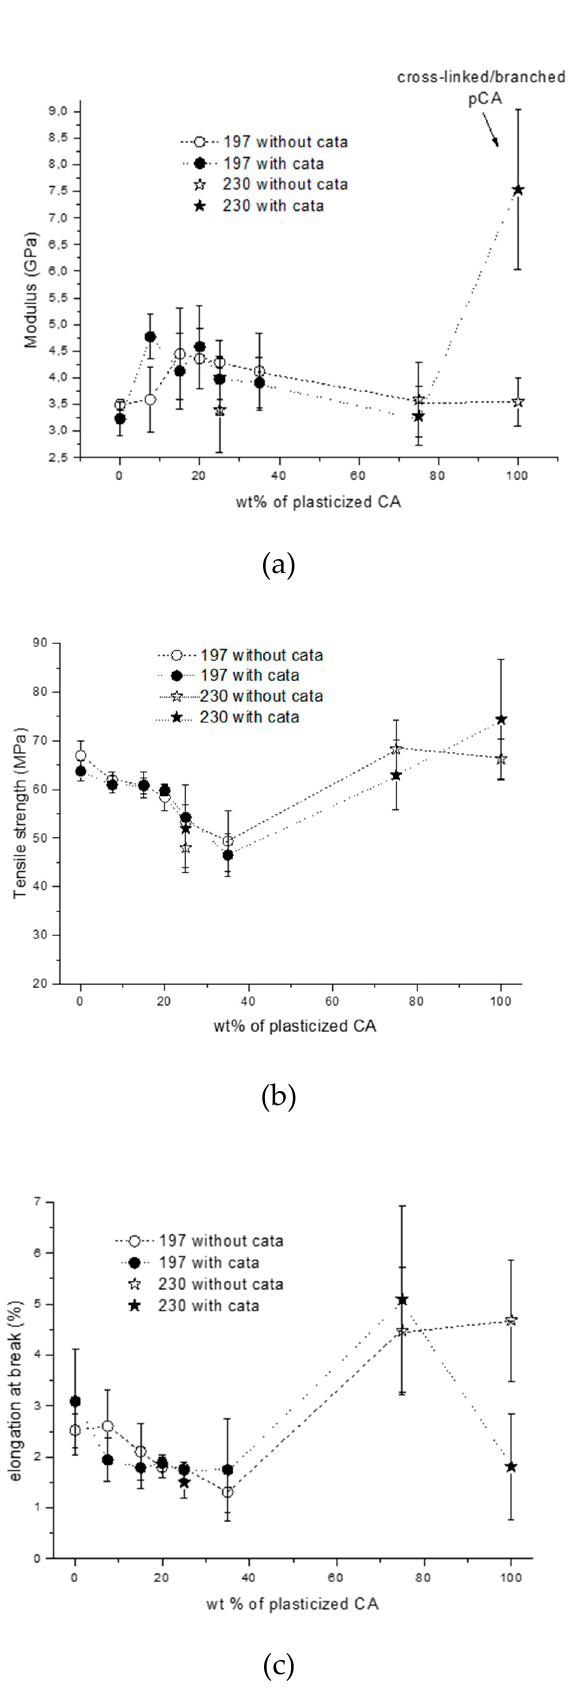
Figure 7. Tensile properties of blends as a function of content of pCA: ( a ) elastic modulus; ( b ) tensile strength; ( c ) elongation at break.